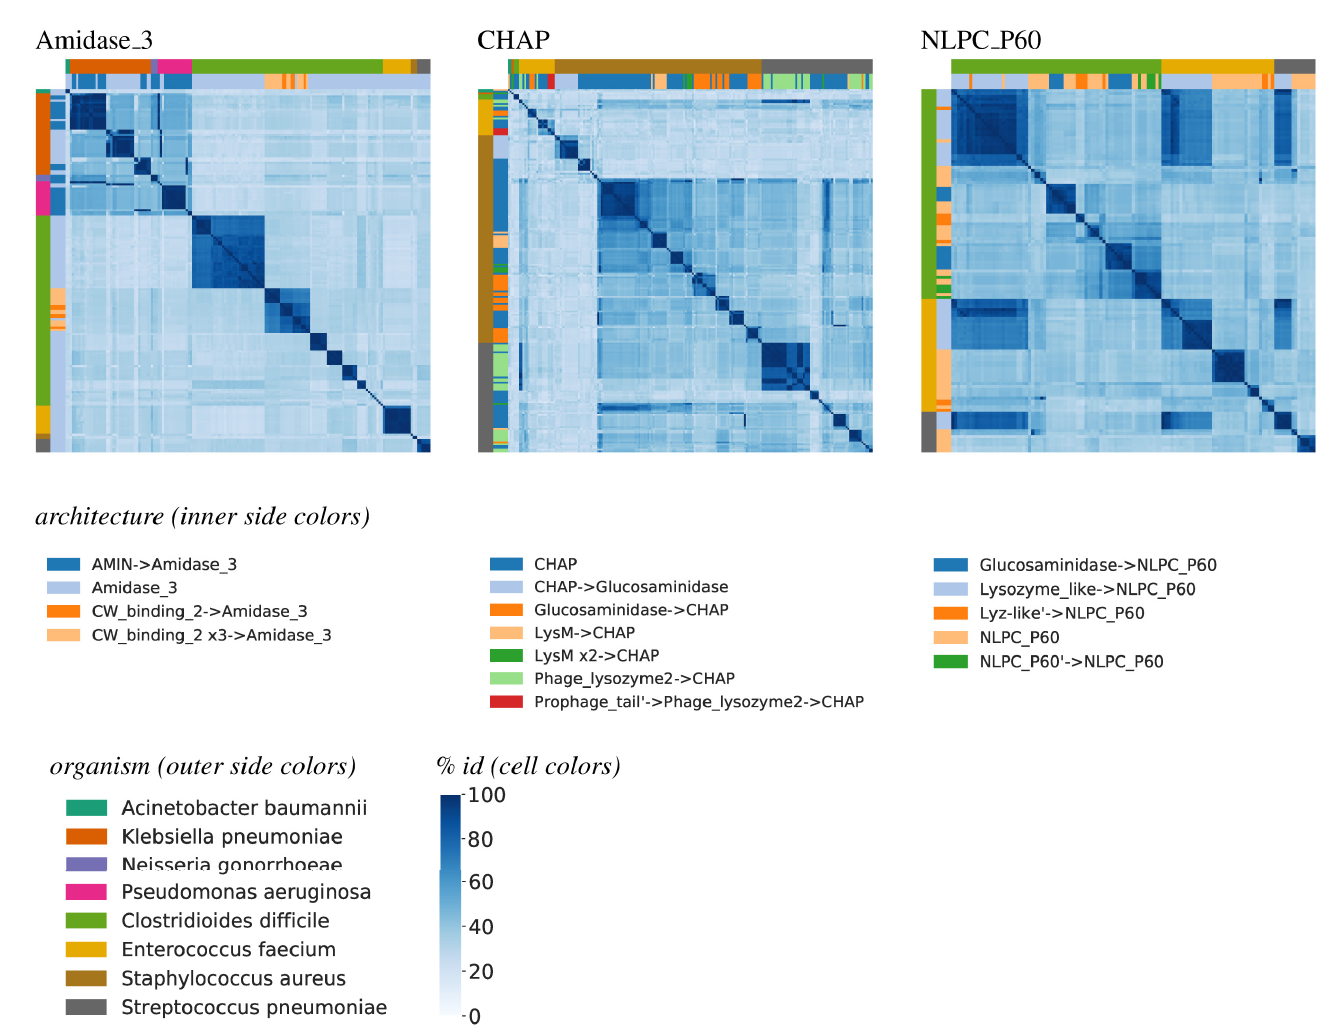
Fig 6. Domain sequence diversity by architecture. Heatmaps as in Fig 5, except limited to non-redundant domain sequences appearing in architectures with a frequency of at least 2% are shown, and with row/column colors indicating the organism and architecture rather than the organism and gram status.